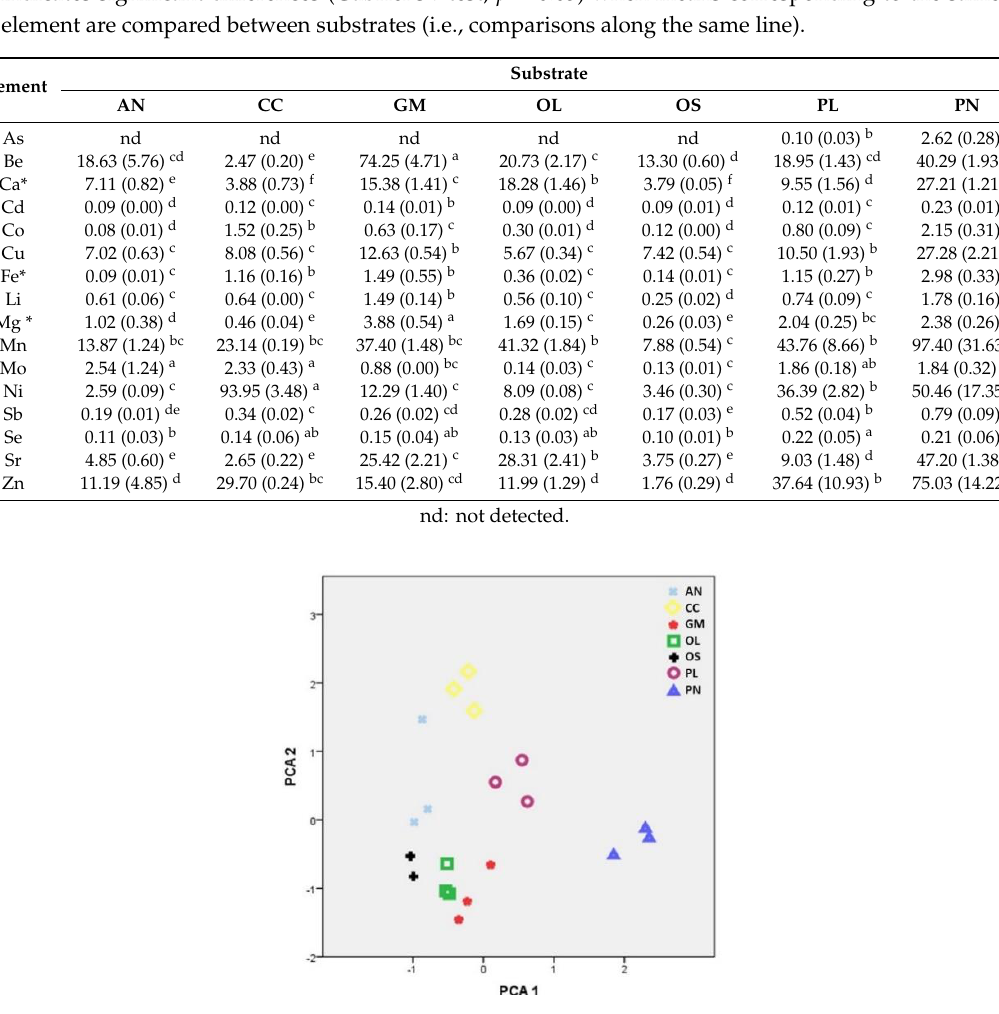
Figure 1. Discrimination of seven mushroom cultivation substrates through principal component analysis by using all element concentration data. Substrates used: AN: almond and walnut shells 1:1 w / w ; CC: corn cobs; GM: grape marc plus cotton gin trash 1:1 w / w ; OL: olive mill by-products (leaves and two-phase olive mill waste 1:1 w / w ); OS: extracted olive-press cake; PL: date-palm tree leaves; PN: pine needles.